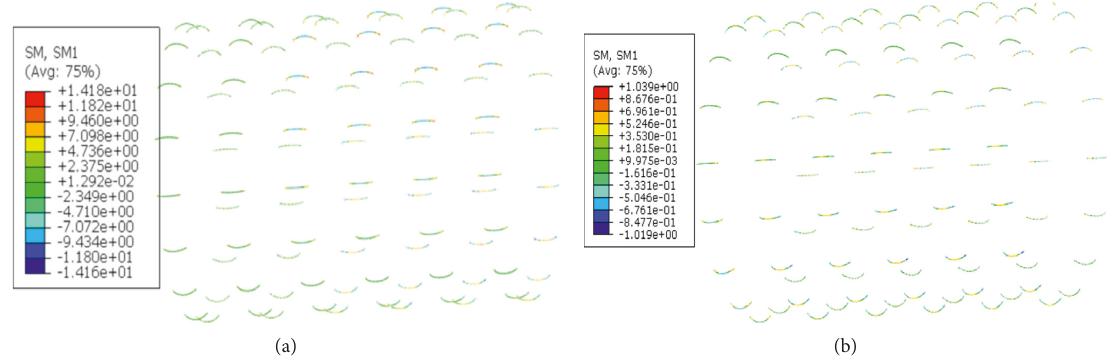
Figure 19: Moment diagram of bolt. Water head difference of (a) 18 m and (b) 0 m.